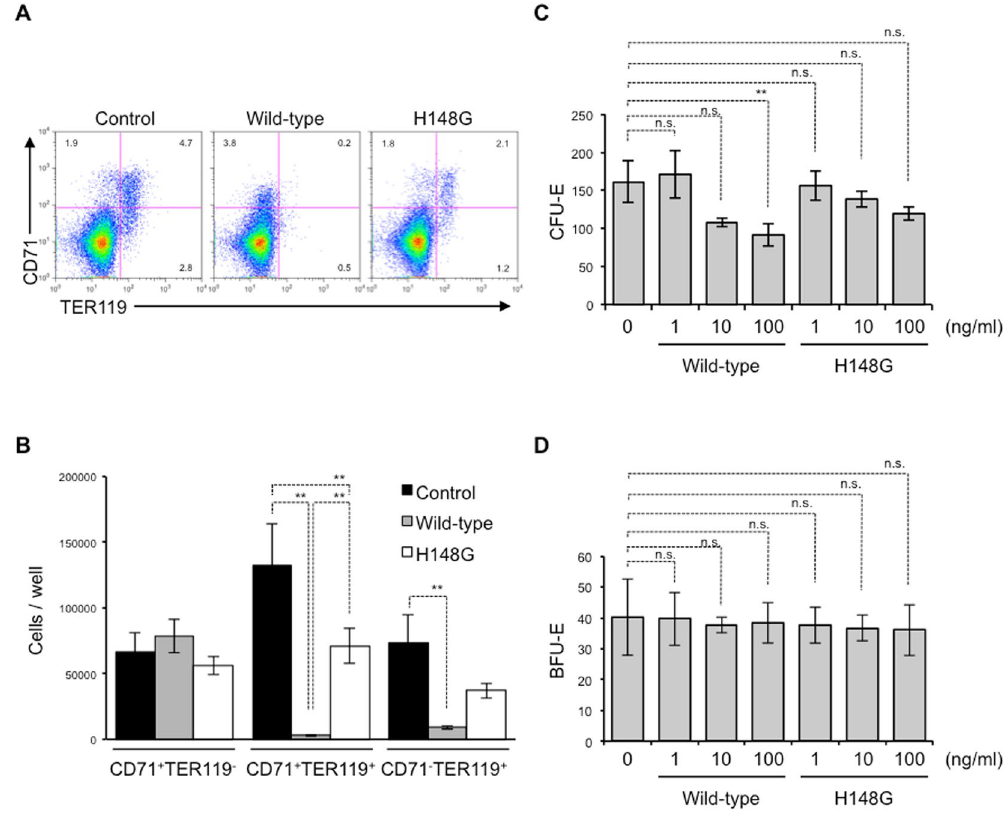
Figure 2. α -Toxin preferentially eradicates mature erythroblasts. ( A , B ) A total of 5 × 10 6 bone marrow cells were cultured for 24 hours in the presence of 10 ng/ml α -toxin (Wild-type) or a variant α -toxin (H148G), and flow cytometry analysis was performed using a Guava easyCyte. ( A ) A representative flow cytometry profile is shown. ( B ) The absolute number of CD71 + TER119 − , CD71 + TER119 + , and CD71 − TER119 + cells per culture well was determined. ( C , D ) Bone marrow cells were treated with the indicated concentration of α -toxin (Wild- type) or a variant α -toxin (H148G), and the cells were plated in Methocult 3334. CFU-E ( C ) and BFU-E ( D ) were determined. One-way ANOVA was employed to assess statistical significance. Values are mean ± standard deviation. ** P < 0.01; n.s., not